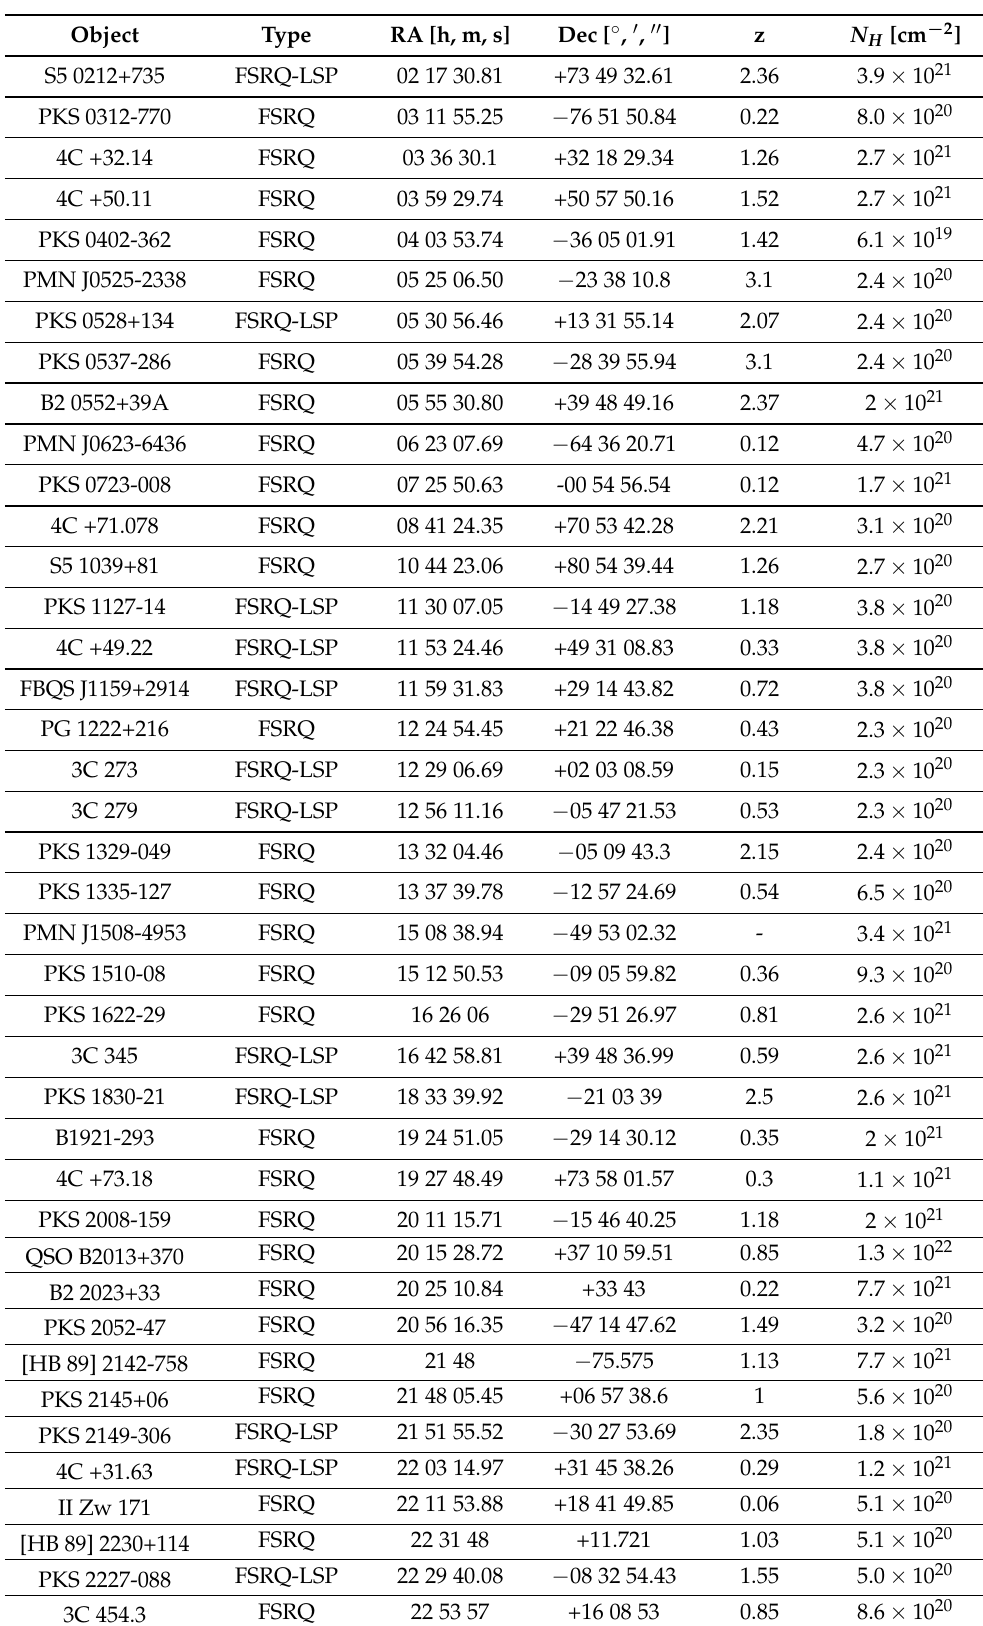
Table 2. Sub-sample of FSRQ type